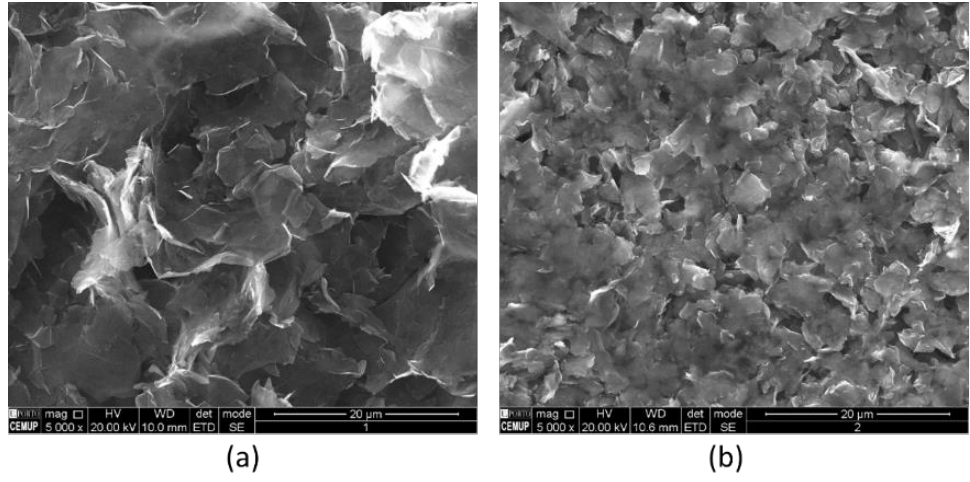
Figure 2. SEM pictures of the G_REF ( a ) and commercial graphite ( b ), at 5000× magnification. Table 3. Surface area, pore volume and average pore size of commercial graphene and graphite materials.